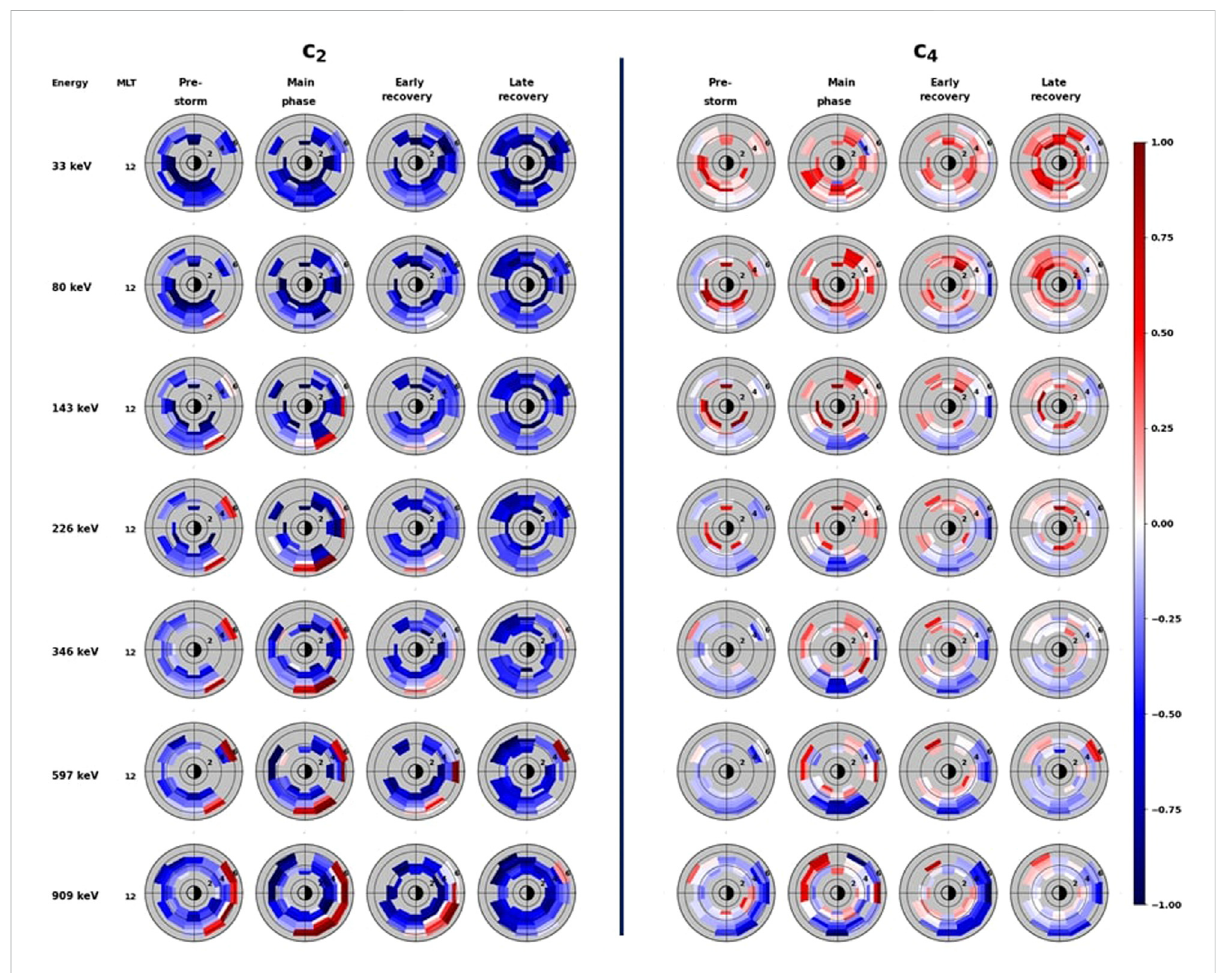
FIGURE 3 Same as in Figure 2 but during corotating interacting region (CIR) driven geomagnetic